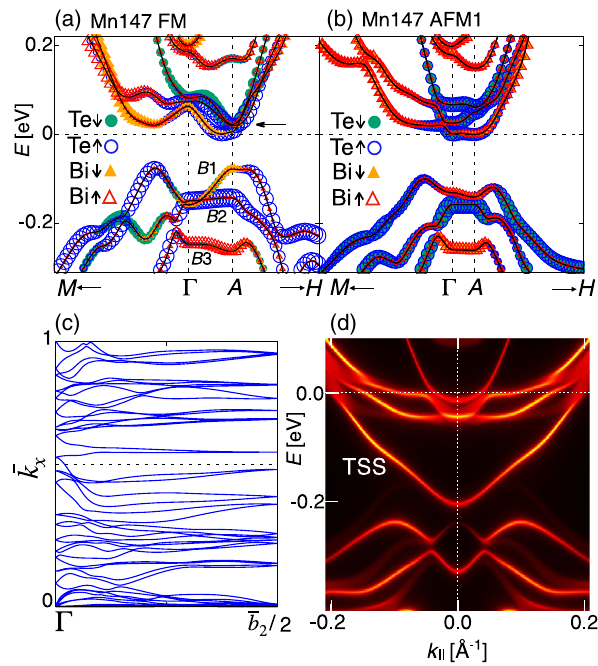
FIG. 4. Band inversion phenomena in Mn147 (GGA þ U þ SOC). (a) Band structure in the ferromagnetic configuration. The symbol size in each k point and band is proportional to the overlap between the corresponding Bloch state and the Te and Bi p orbitals, respectively, depicted in different colors. Filled (empty) dots correspond to spin-down (spin-up). The black arrow indicates the energy of the Weyl node of lowest energy in the conduction band. (b) Band structure for the antiferromagnetic AFM1 configuration. (c) Wannier center evolution in the k plane. k is the crystal momentum along the primitive lattice x ¯ ¯ b 1 and b 2 is the second primitive vector in the k vector plane. (d) Mn147(0001) surface spectral density along the direction for a quintuple layer